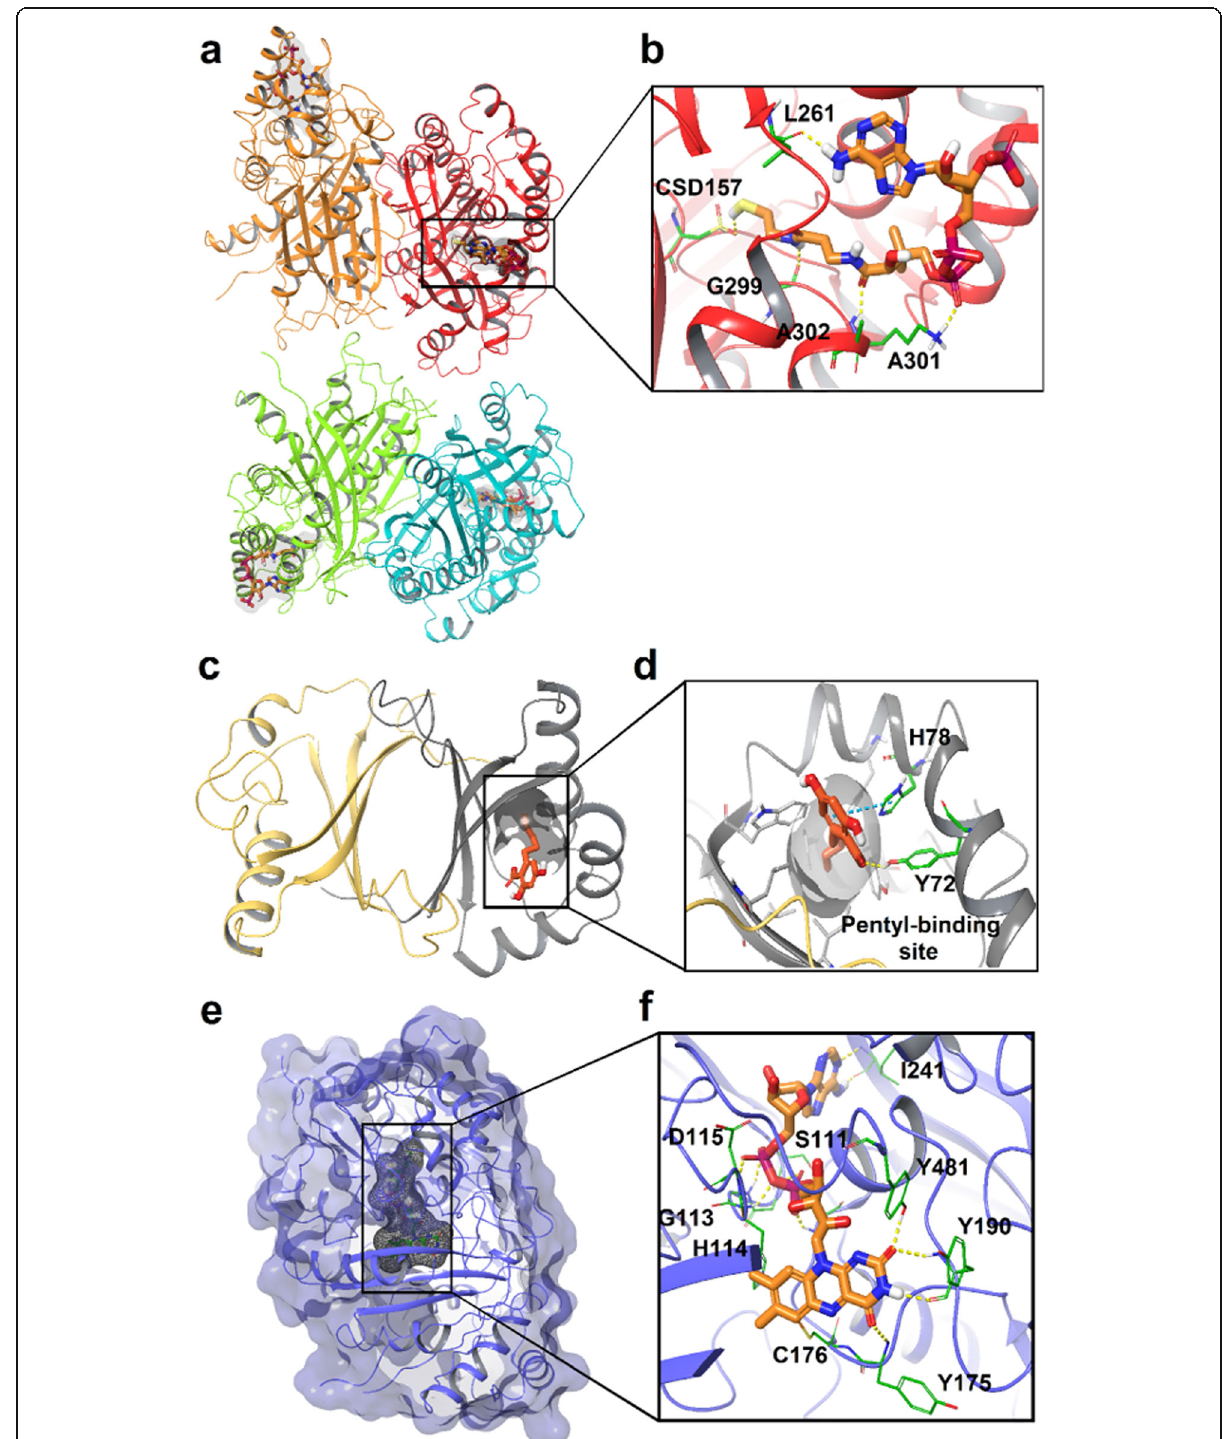
Fig. 3 X-ray diffraction structures of three key enzymes implicated in cannabinoid biosynthesis. Key active site residues are highlighted in green, and interaction diagrams, generated by the authors using the Schrödinger computational software suite (Maestro 2020), of a ) tetrameric tetraketide synthase (TKS) from C. sativa in complex with CoenzymeA (CoA, 6GW3 ), CoA is orange, with the four tetramers in red, orange, light green and cyan respectively (Kearsey et al. 2020); b ) expansion of the active site; c ) Olivetolic acid cyclase (OAC) from C. sativa ( 5BO9 ) (Yang et al. 2016), the pentyl-binding pocket and its key residues are gray, olivetolic acid (OLA) is orange, chain A is gray and chain B is in light orange; d ) expansion of the active site, inverted; e ) tetrahydrocannabinolic acid synthase (THCAS) from C. sativa ( 3VTE ) bound to flavin adenine dinucleotide (FAD) and without ligand. FAD is orange and the protein navy; and f ) expansion of the active site (Shoyama et al.